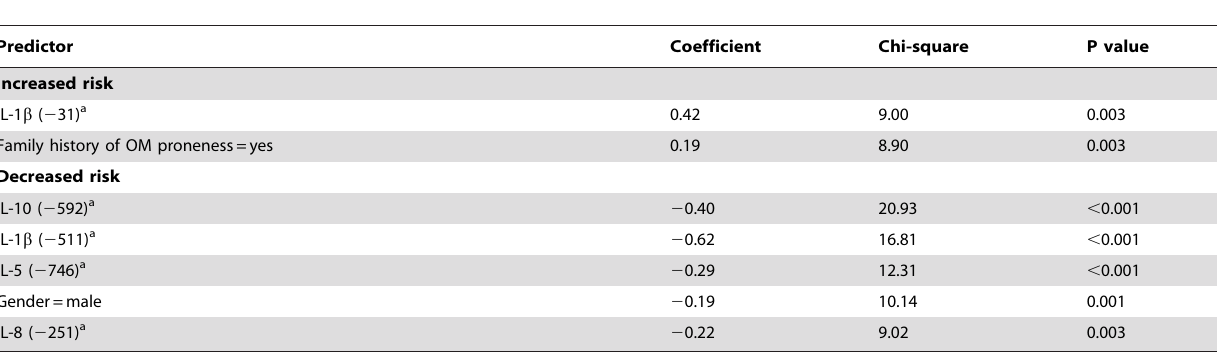
Table 4. Poisson multiple regression ( R 2 =0.17) model to predict the number of URI episodes in 202 children of the prospective study cohort.